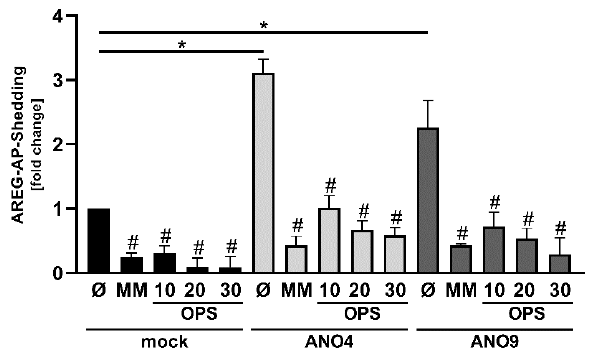
Figure 6. Increased constitutive AREG release in ANO4- or ANO9-transfected cells is inhibited by MM and OPS. HEK293T cells were co-transfected with ANO4 (light grey columns) or ANO9 (dark grey columns) or mock vector (black columns) and the AP-tagged substrate AREG. Forty-eight hours after transfection, cell media were replaced by serum-free media and cells were incubated in the absence or presence of the inhibitors MM (10 µ M) or OPS (10 mM, 20 mM, and 30 mM) for 30 min followed by analyses for the release of soluble AREG via AP-Assay. * indicates a significant increase, and # indicates a significant decrease compared to corresponding untreated cells (n = 4; * p < 0.05; ± SEM). Data were analyzed by one-way ANOVA and Holm–Sidak multiple comparison post hoc